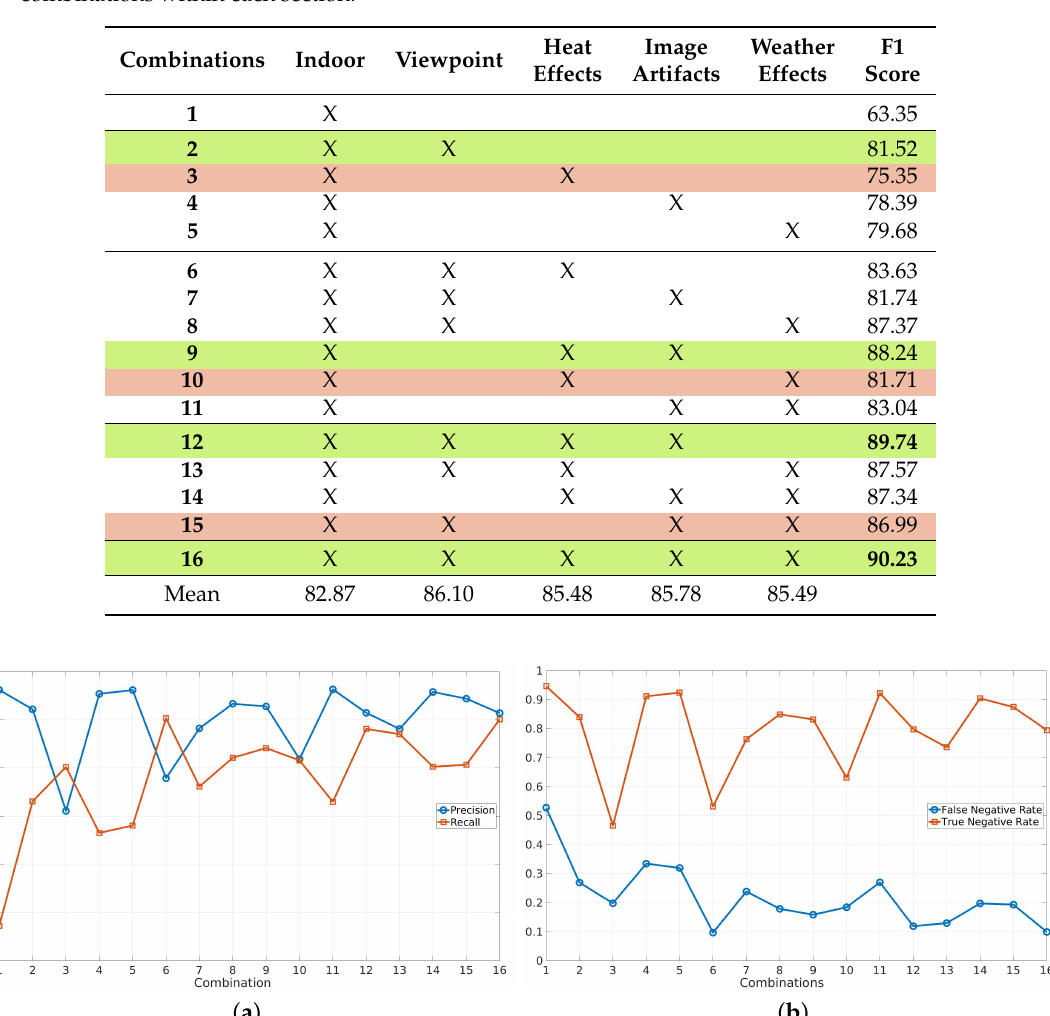
Table 4. F1 score of combinations. Here, X indicates the category added in a combination. Other than indoor data, Combinations 2–5 only had one category of images, Combinations 6–11 two categories of images, and Combinations 12–15 three categories of images. Lastly, Combination 16 had all categories. The red color shows the worst-performing combinations, and the green color shows the best performing combinations within each section.